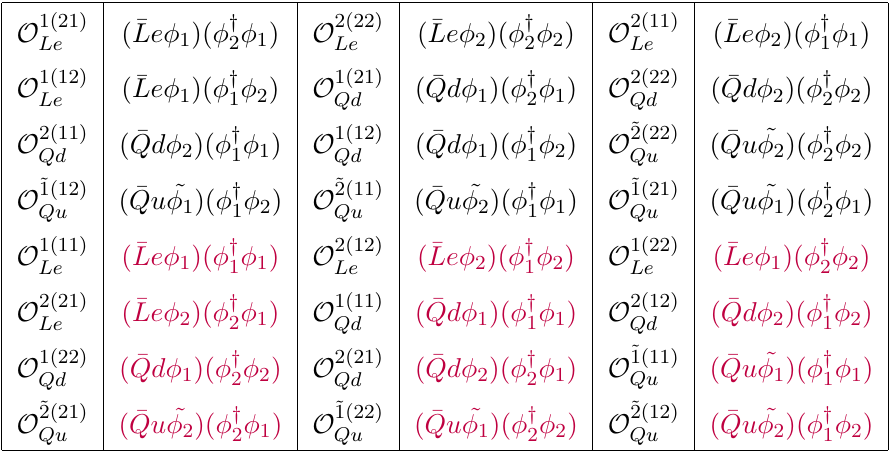
Table 8. 2HDM: 2 (cid:30) 3 [24 2 = 48] class of operators. Each of these operators also has a distinct (cid:2) Hermitian Conjugate.